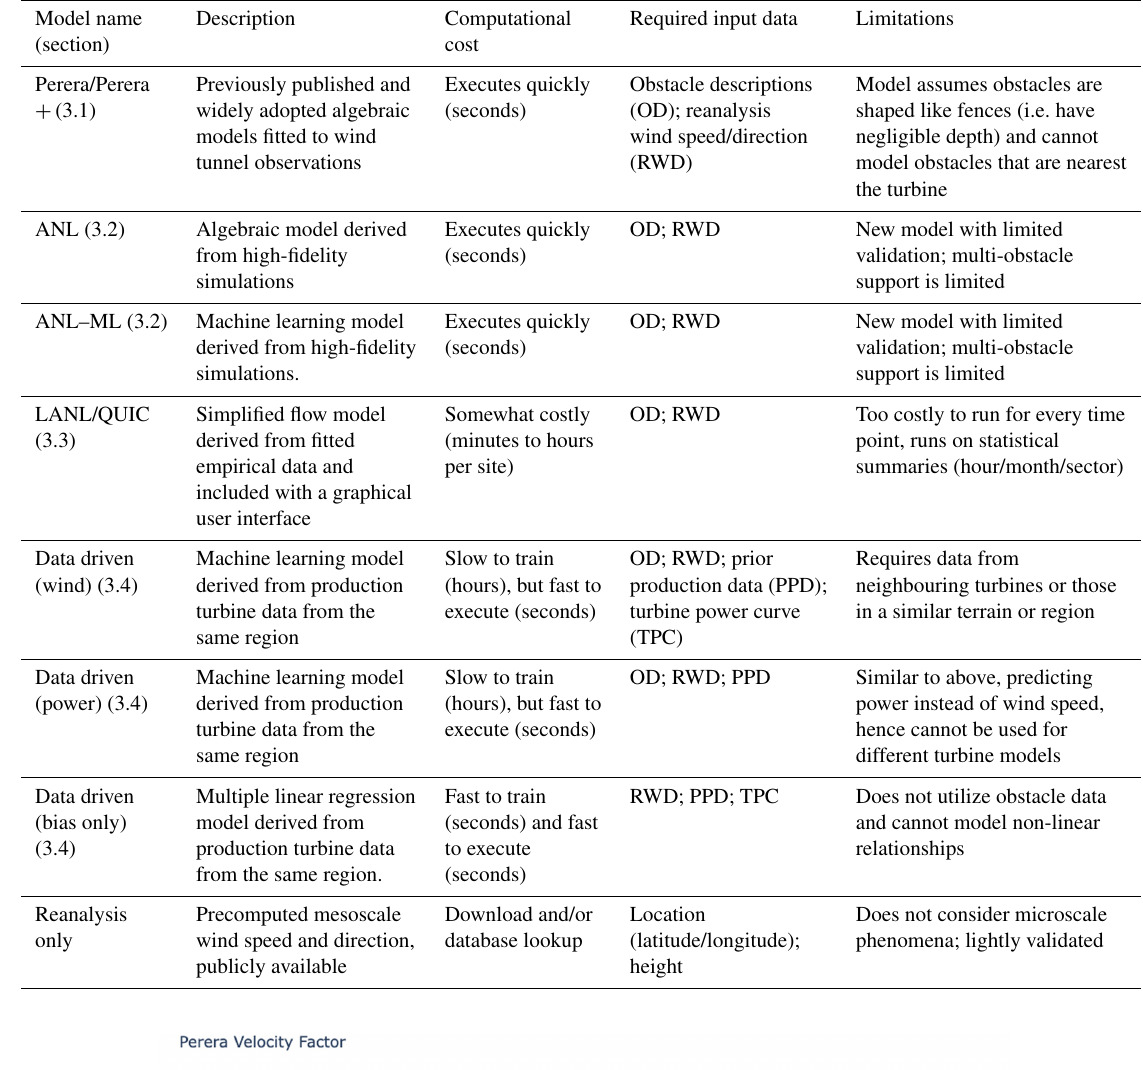
Table 2. Summary of models evaluated.